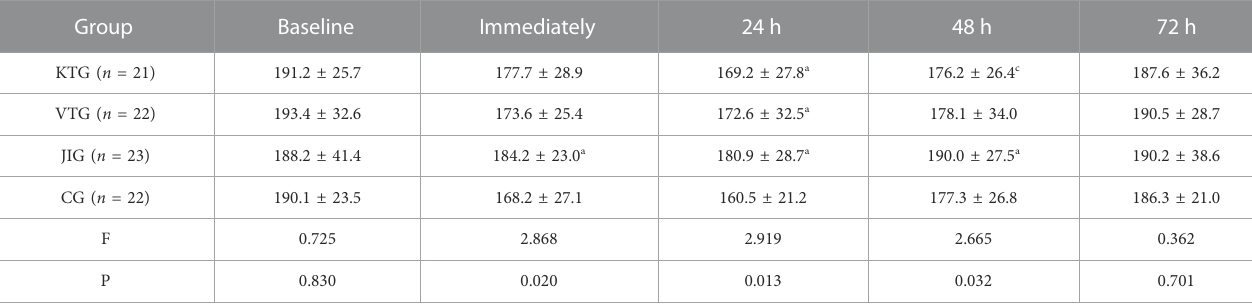
TABLE 3 MIVC Test for Knee Extension at different times. (Nm).